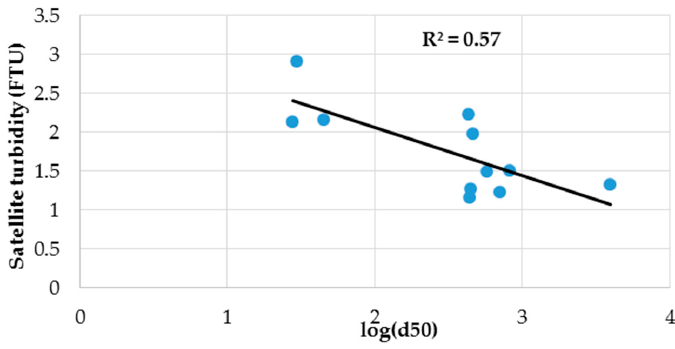
Figure 14. Correlation between Landsat 8 OLI extracted turbidities and log (d 50 ).